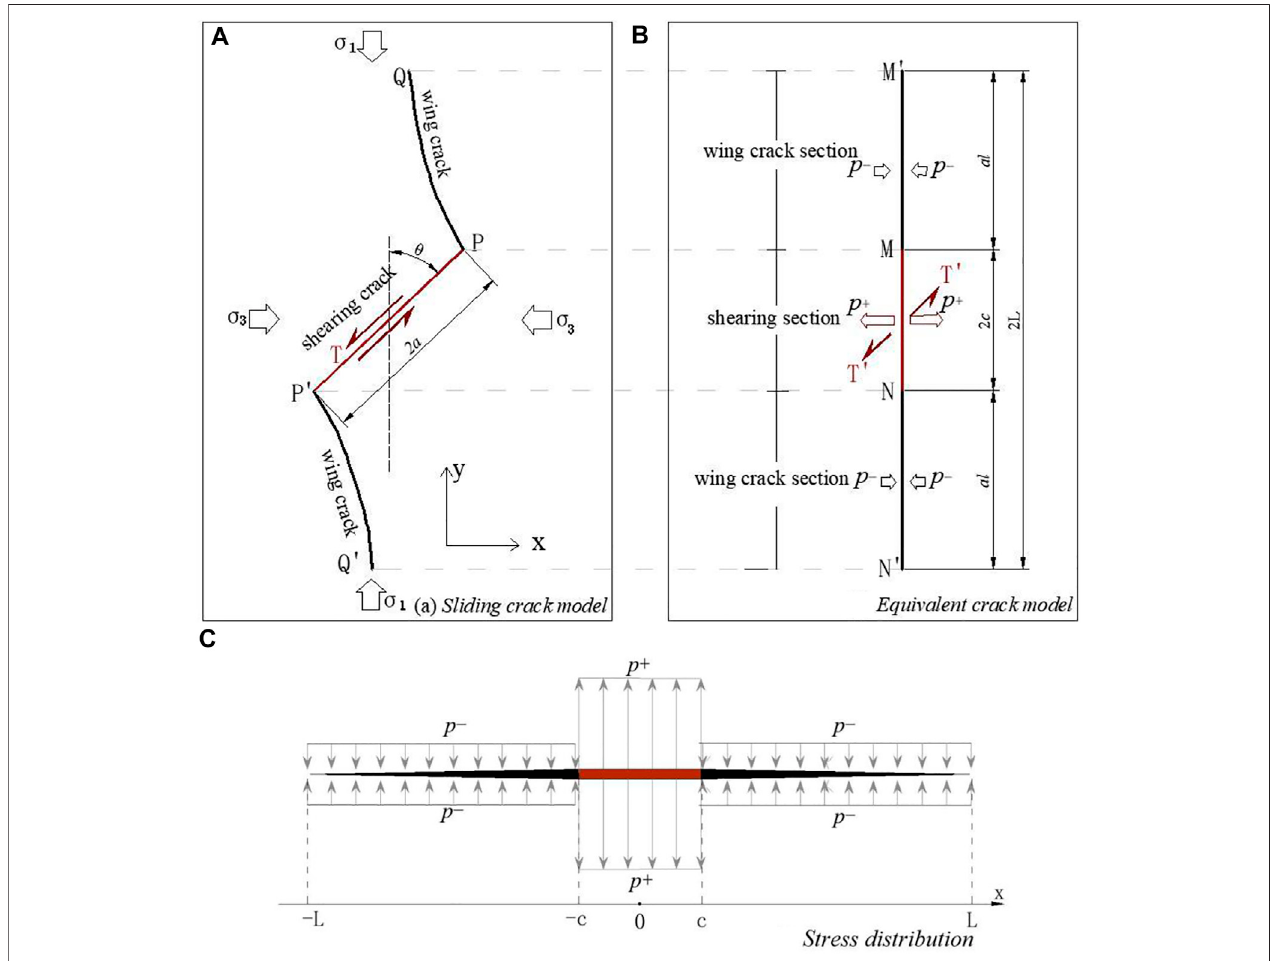
FIGURE 3 | Analytical model of a sliding crack. (A) Sliding crack model and (B) equivalent crack model. (C) Stress distribution on the equivalent crack model.